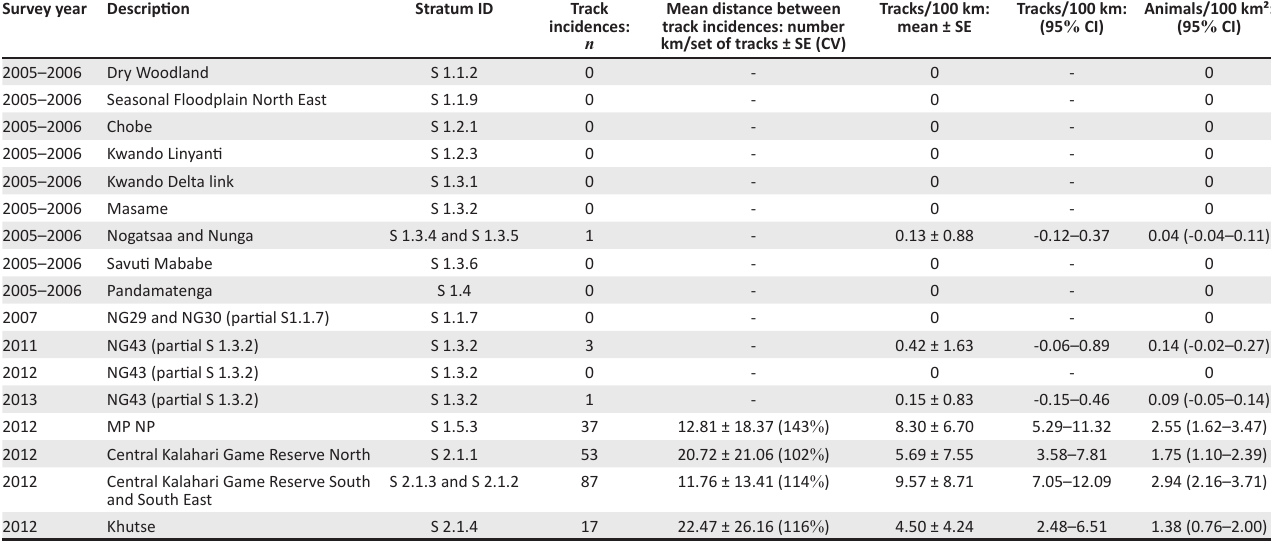
TABLE 2: Results of track surveys completed between 2005 and 2013 to estimate brown hyaena ( Parahyaena brunnea ) densities in study areas across Botswana. Survey year